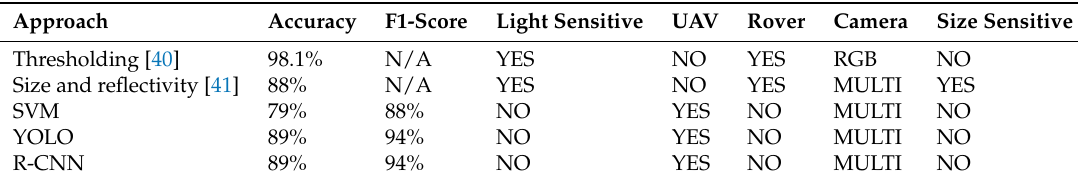
Table 4. Comparison between lettuce detection